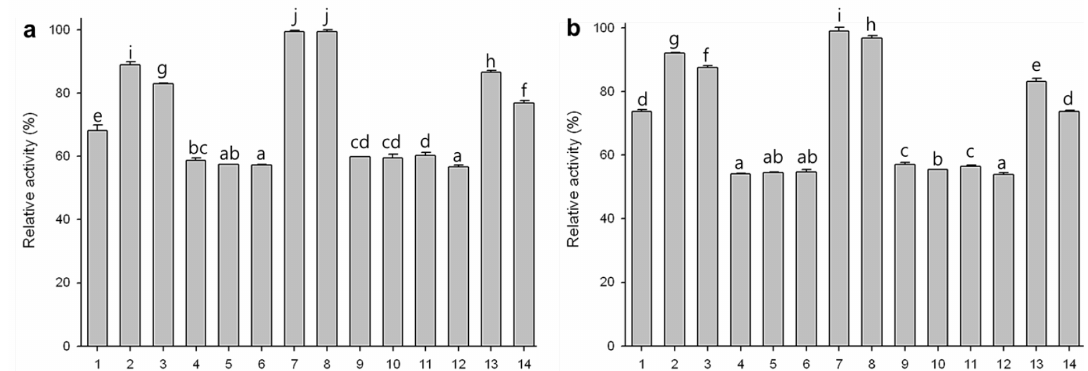
12, glucose-1-phosphate; 13, acetyl phosphate; 14, sodium phytate. Data are expressed as the relative activity and each value represents the mean ± SE ( n = 3). Different letters indicate significant differences ( p < 0.05).